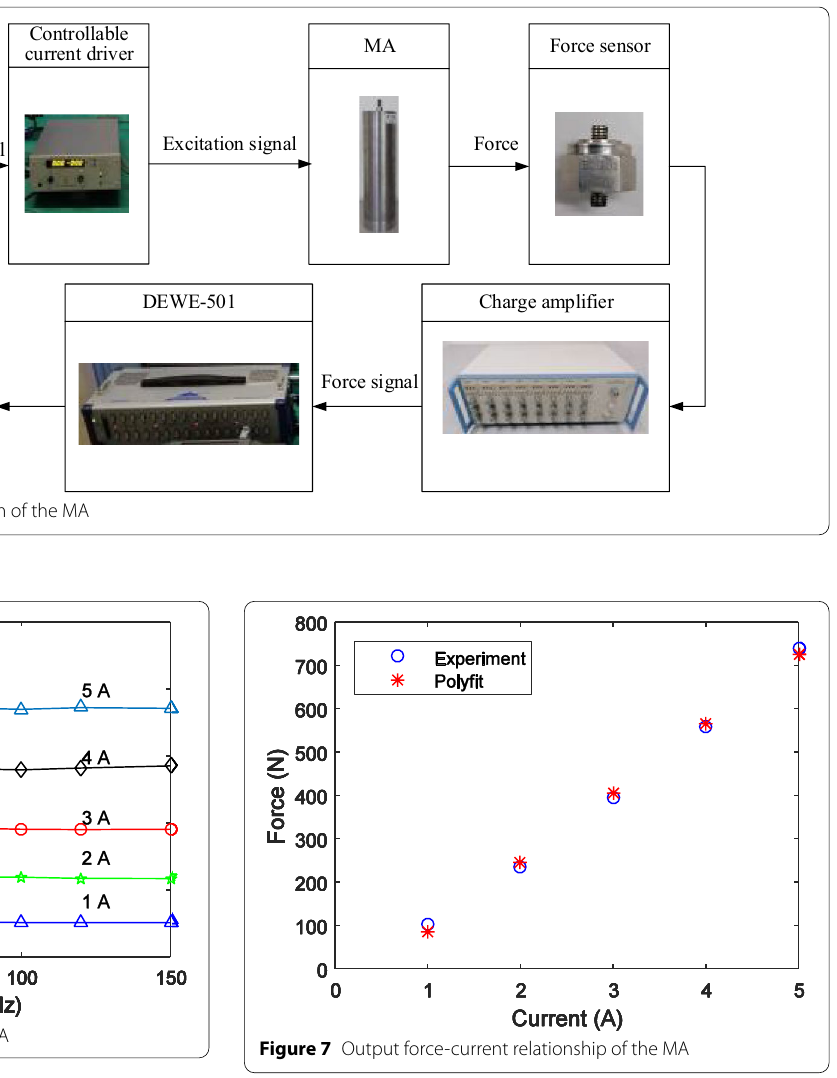
and relative variation E max relative